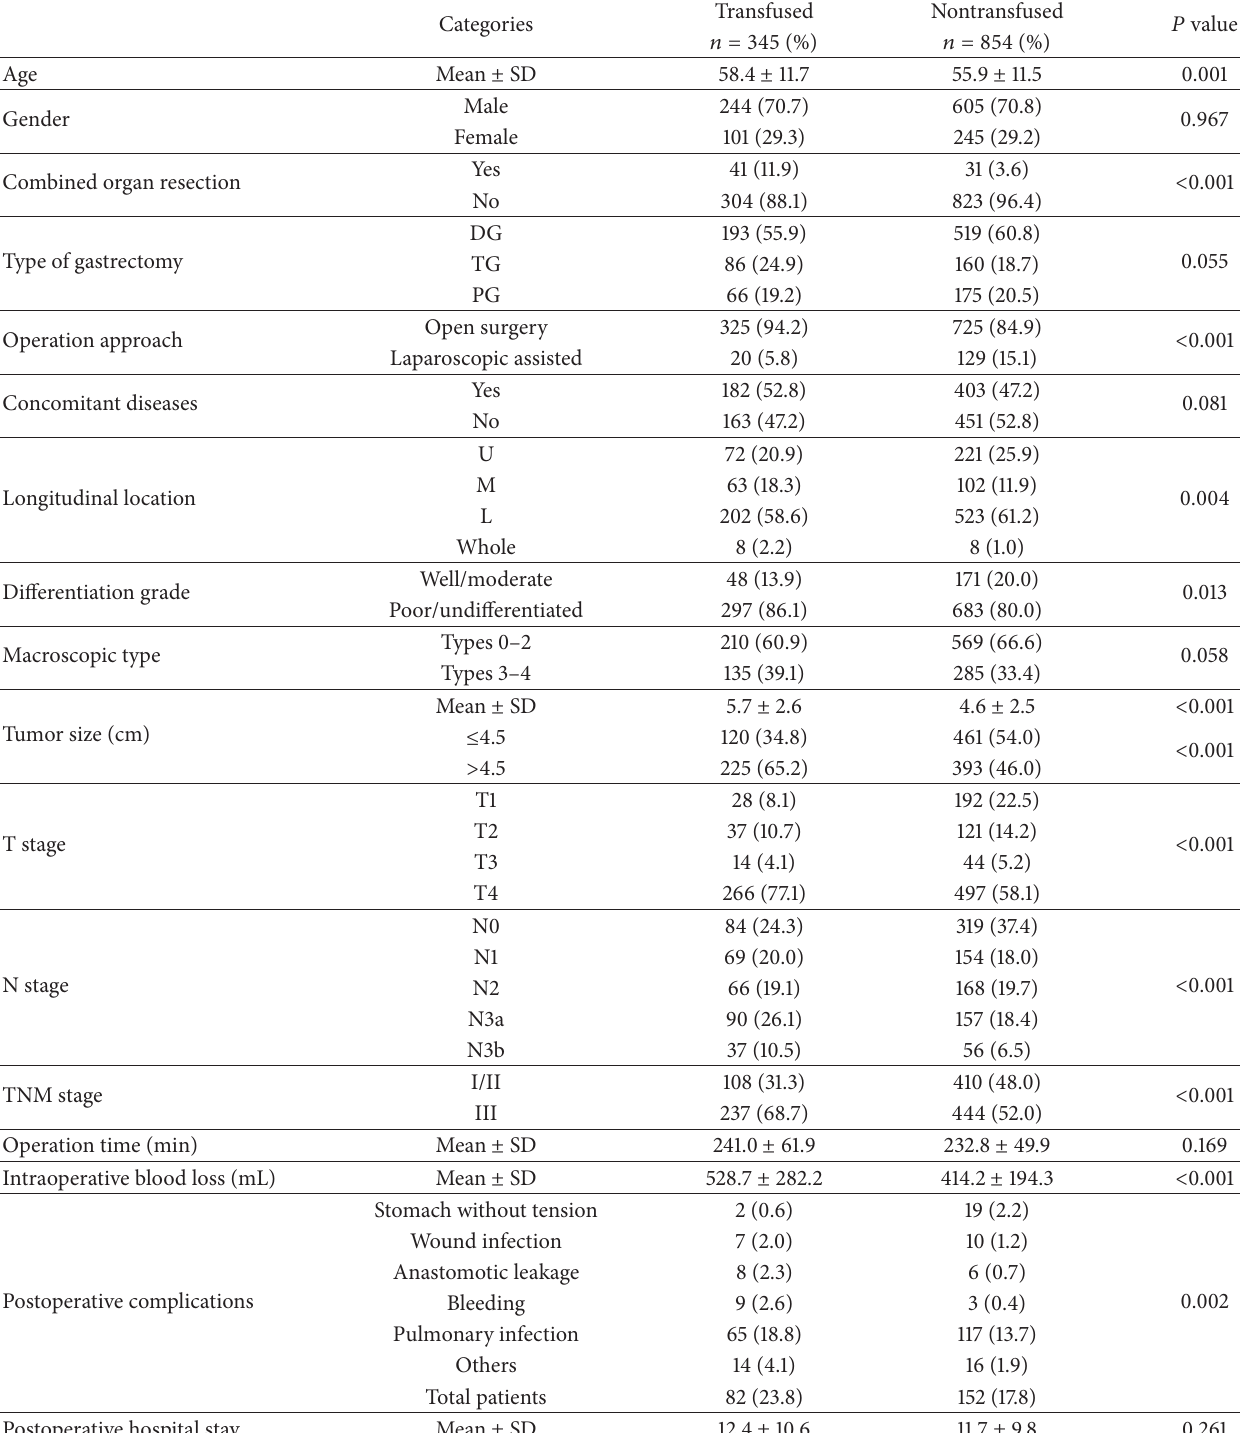
Table 1: Comparison of clinicopathological features of all transfused and nontransfused